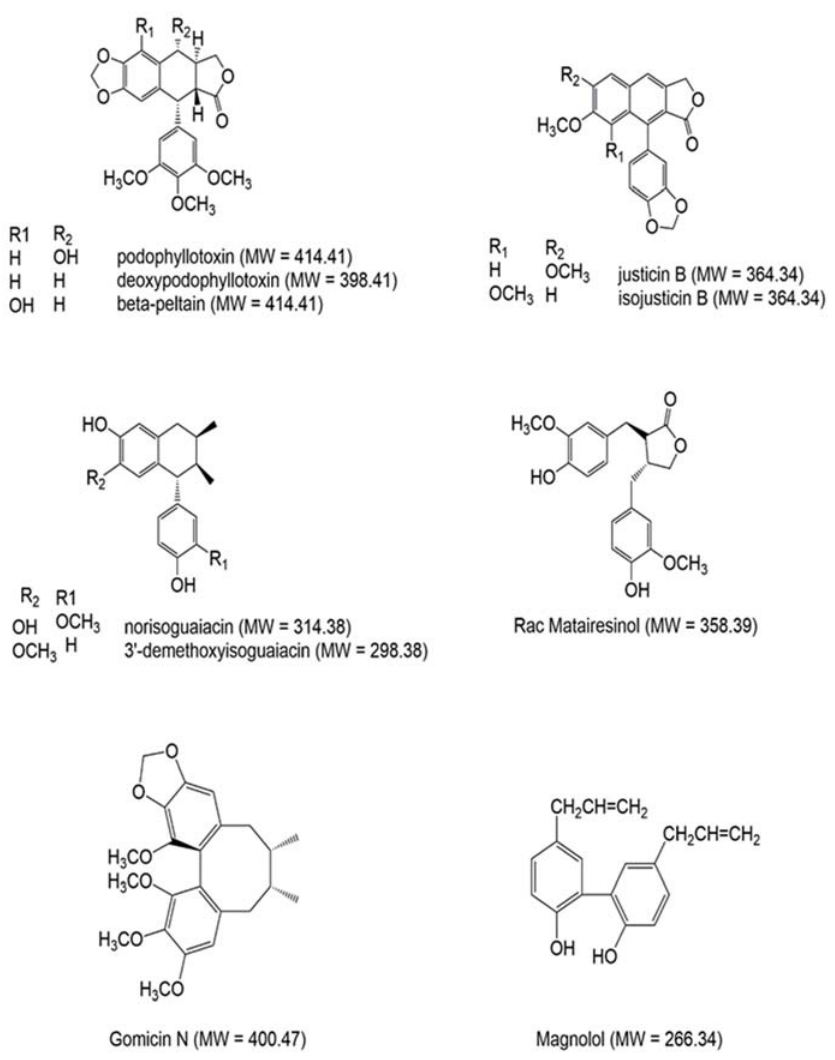
Figure 1. Example of selected natural products found in Larrea tridentata (LT) plant.